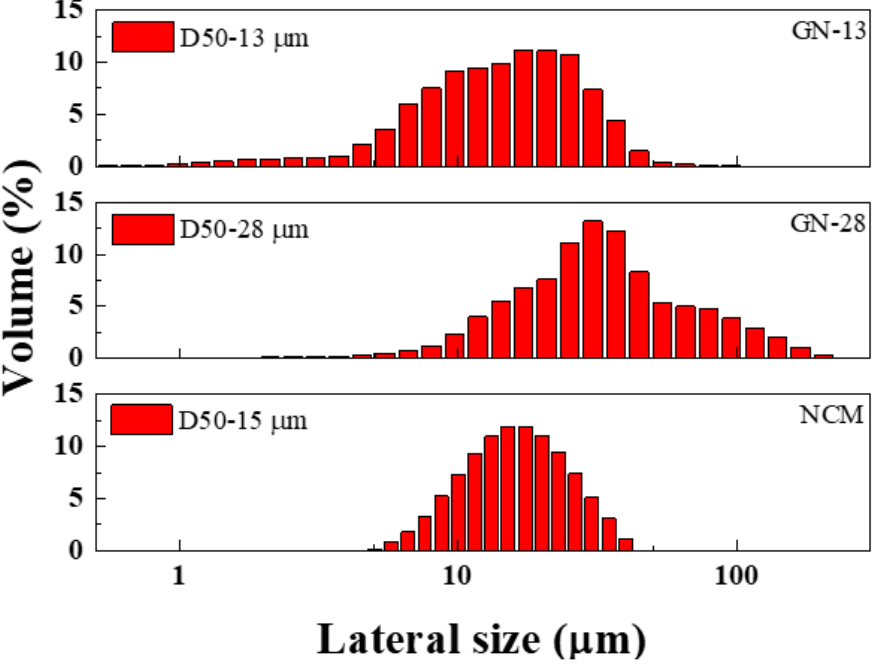
Figure 4. Lateral size distribution of GN-13 and GN-28 and NCM samples. Polymers 2020 , 01 , x FOR PEER REVIEW